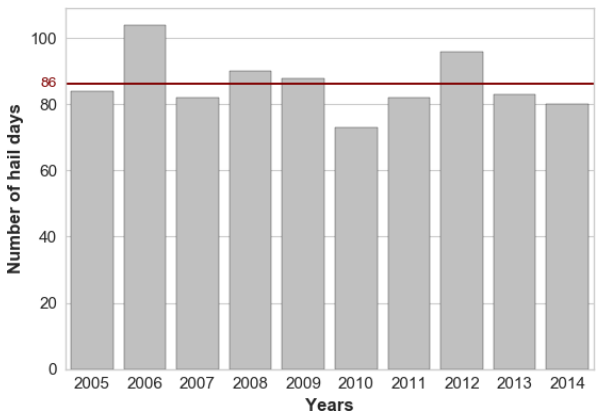
Figure 5. Yearly number of hail days per year from 2005 to 2014. The red line indicates the overall mean of hail days from 2005 to